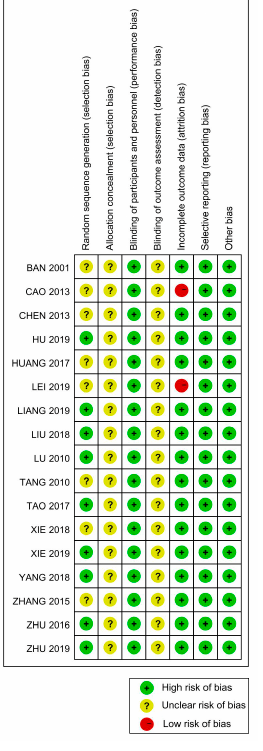
Figure 3. Summary of the risk of bias of included studies.